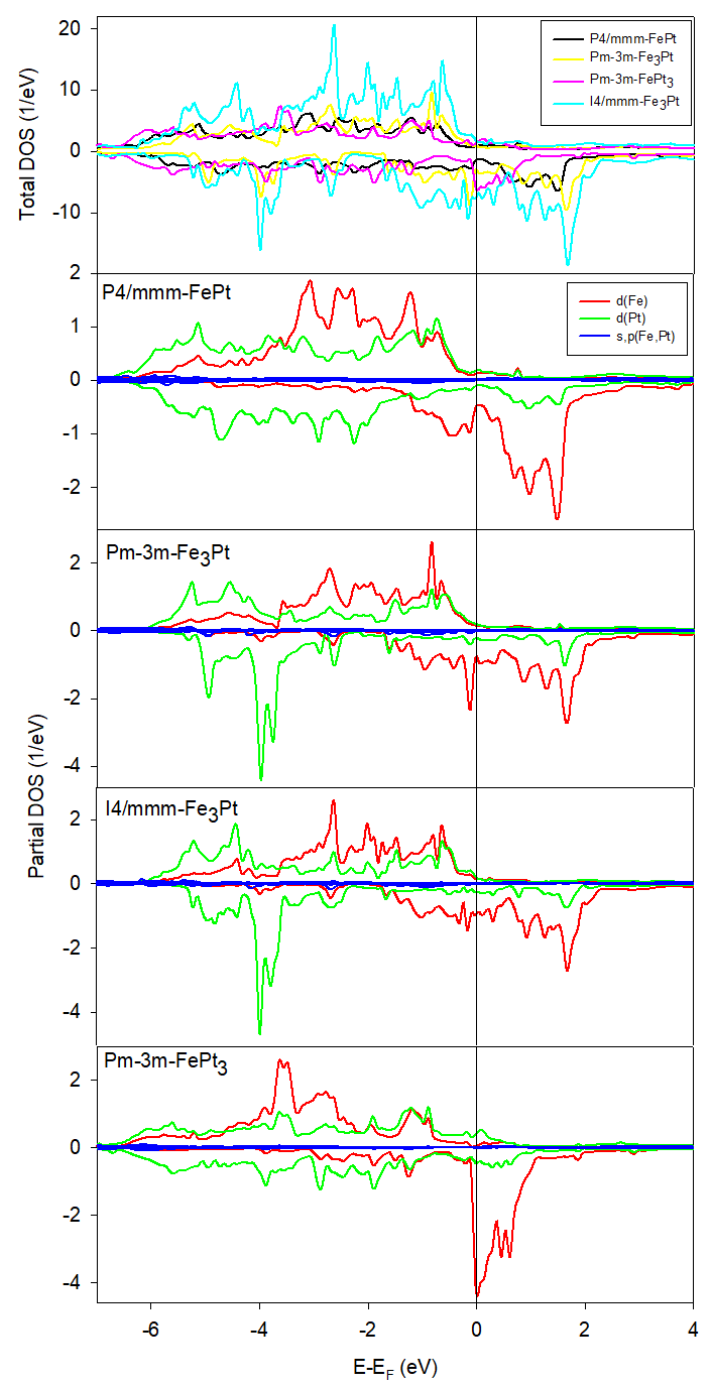
Figure 3. Total and orbital projected partial density of states for Fe-Pt alloys. The Fermi energy was used as the zero of the energy scale ( 𝐸 = 𝐸 − 𝐸 (cid:3007) ). used as the zero of the energy scale ( E = E − E F